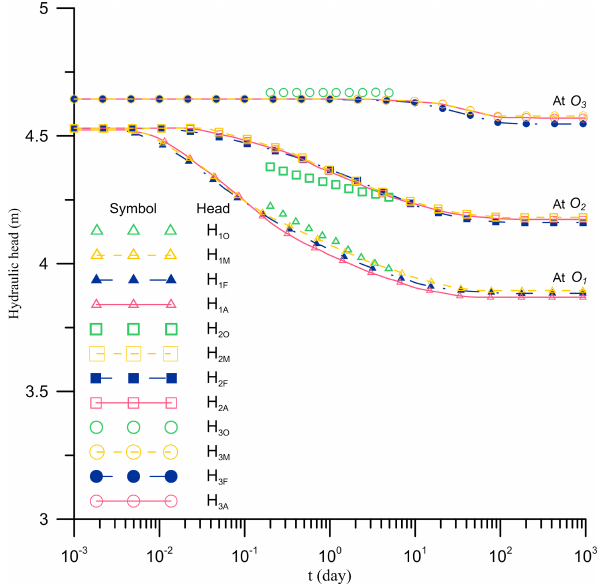
Figure 6. Temporal distributions of the hydraulic head observed at piezometer O i , H i O , and H i F are, respectively, the observations and FEM simulations reported in Kihm et al. (2007); H i A and H i M are the prediction of the present solution and MODFLOW, respectively, for i = 1, 2, 3.